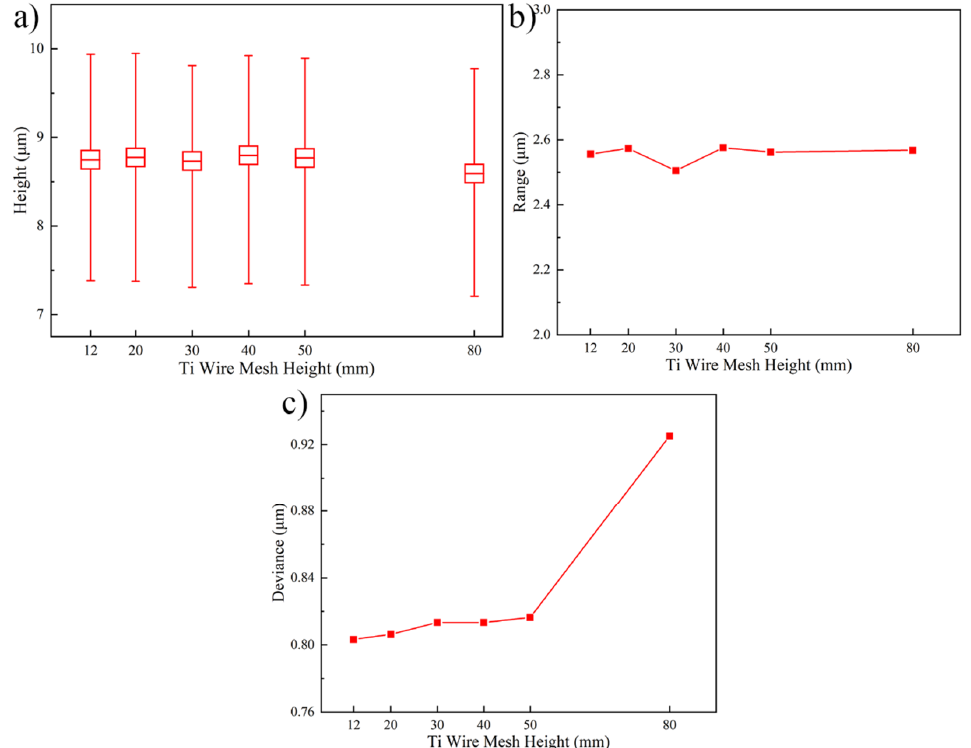
Figure 9. Au bump height and uniformity under different Ti wire mesh heights. ( a ) Au bump height, ( b ) Au bump range, and ( c ) Au bump deviance.